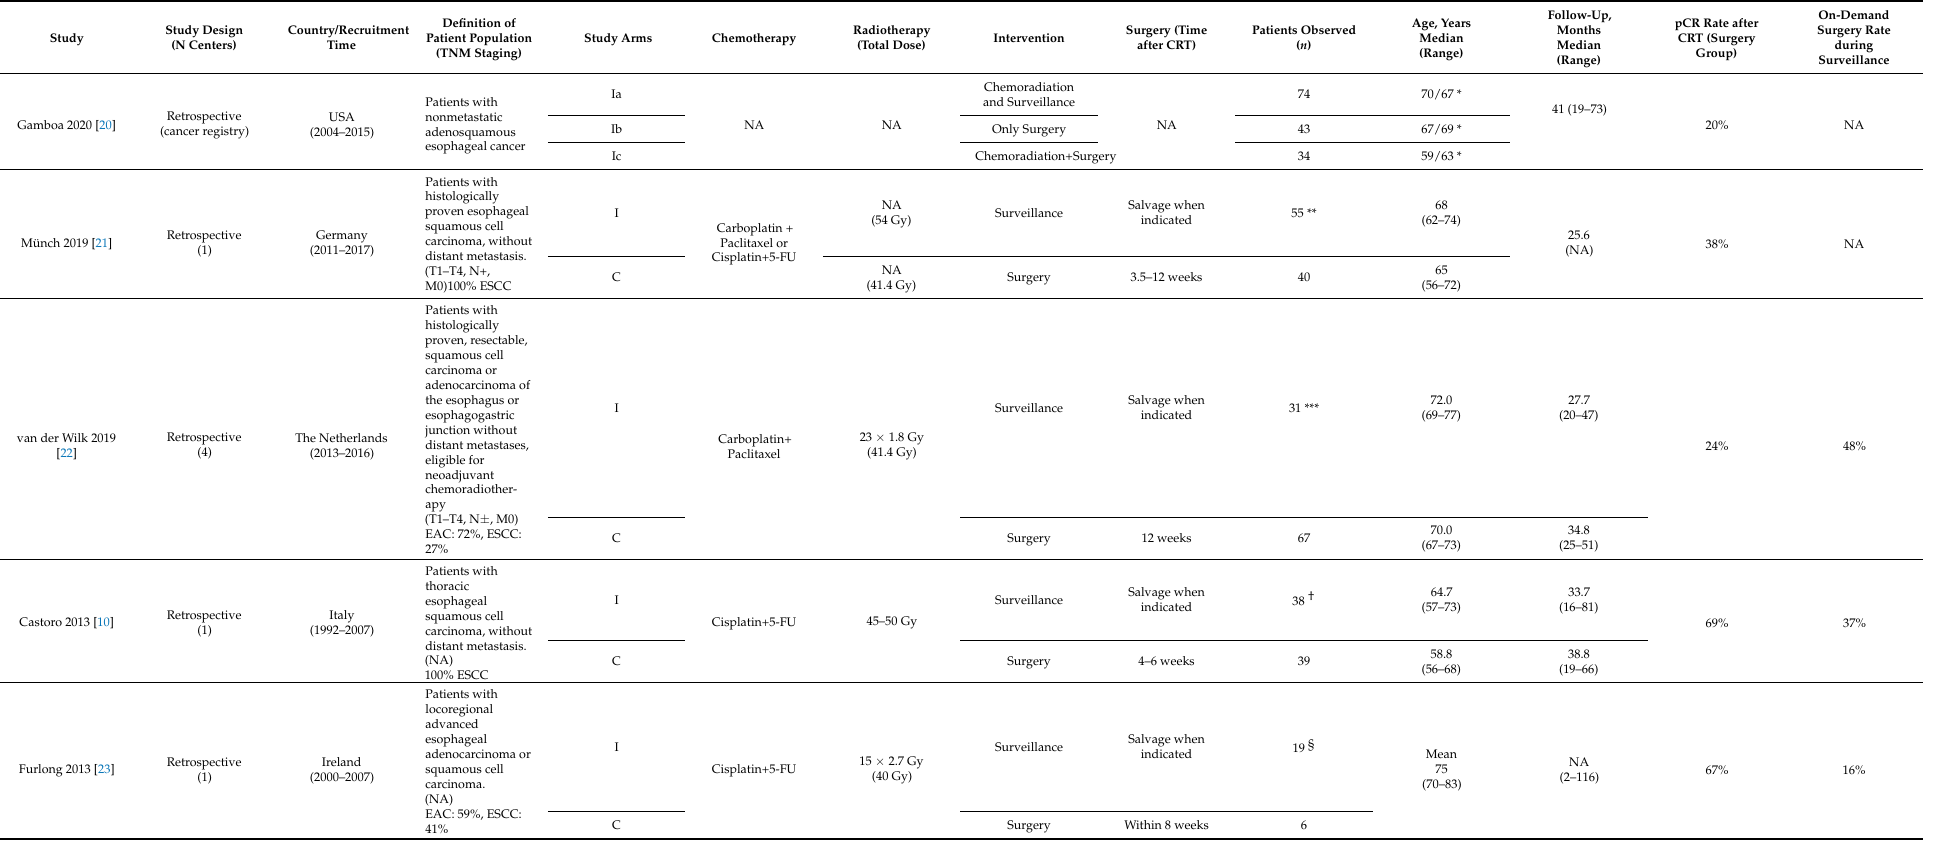
Table 2. Characteristics of observational